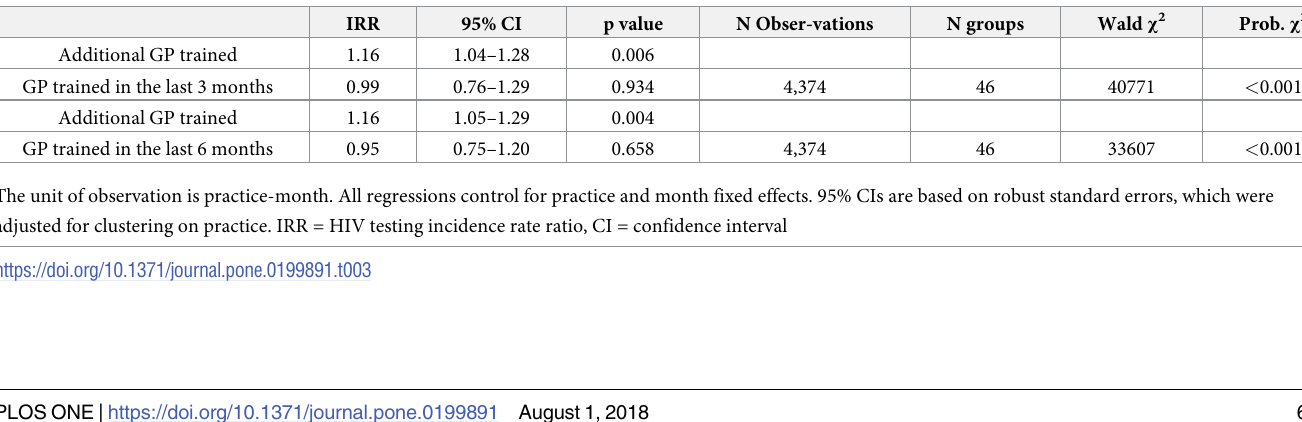
Table 3. Testing SHIP training for short term